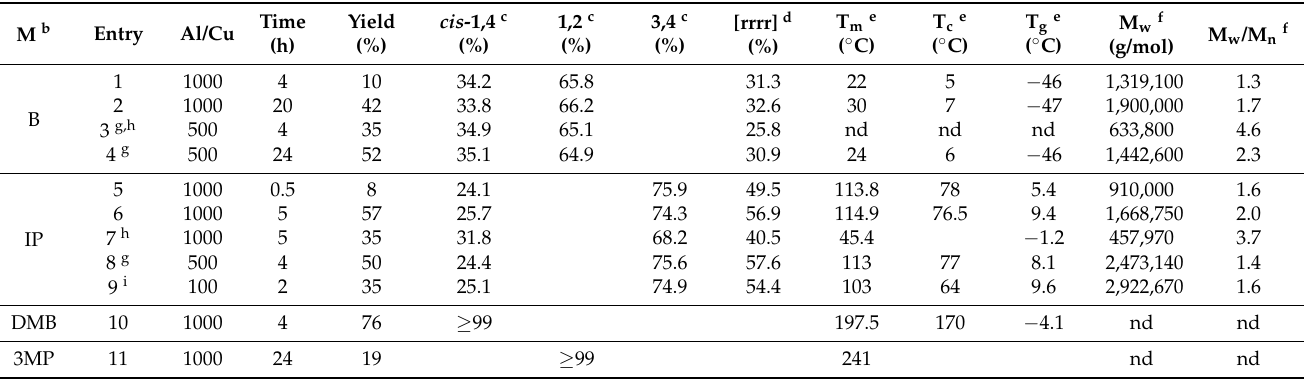
Table 1. Polymerization of 1,3-Dienes with CuCl 2 (bipy)/MAO Catalyst a